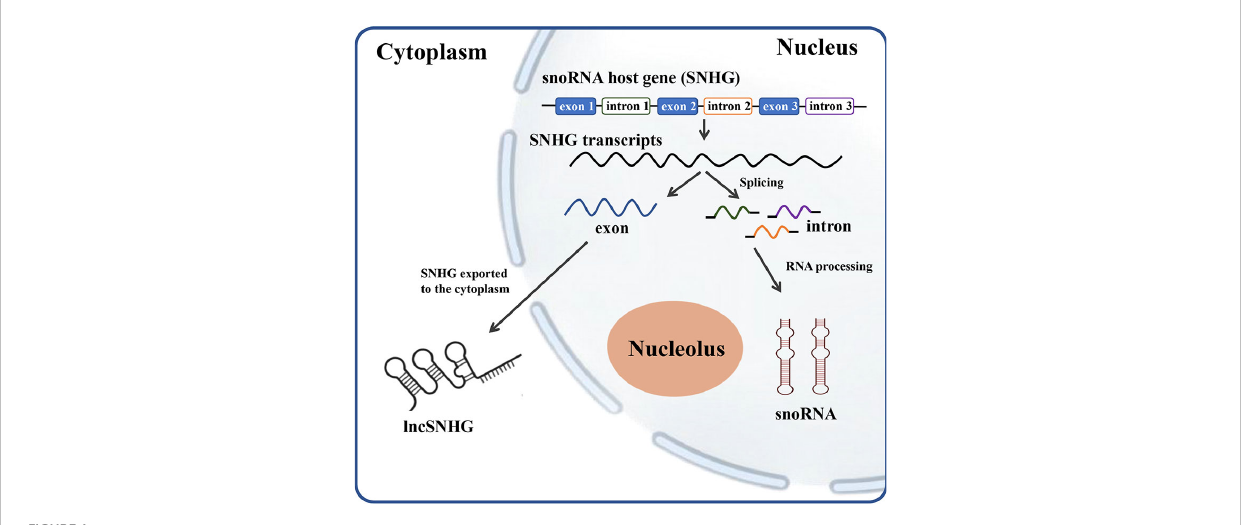
FIGURE 1 The scheme of relationship between SNHG, snoRNA and lncSNHG. The majority of small nucleolar RNA host genes (SNHGs) are protein-coding and non-protein-coding Genes. SNHGs are transcript into the primary SNHG transcripts at nucleus. The primary SNHG transcripts containing all exons and introns with their snoRNAs are cut into different exons and introns. Exons are then re-spliced and translocated into cytoplasm to function as protein coding mRNA or non-coding RNA (lncSHNG). Intronic sequences are further processed into mature snoRNA and then assembled into small nucleolar ribonucleoprotein particles (snoRNPs), which is followed by localization to Cajal bodies and nucleolus. Exon, mRNA or lncRNA exons; intron, mRNA introns that contains the intronic